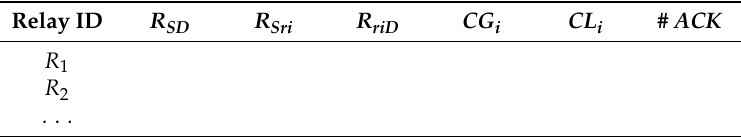
Table 3. CoopTable of the FC-MAC